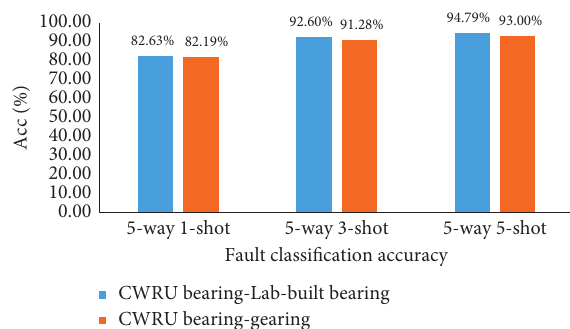
Figure 8: The fault classification accuracy using the trained model under the new fault category. Table 5: Fault classification results of different models.